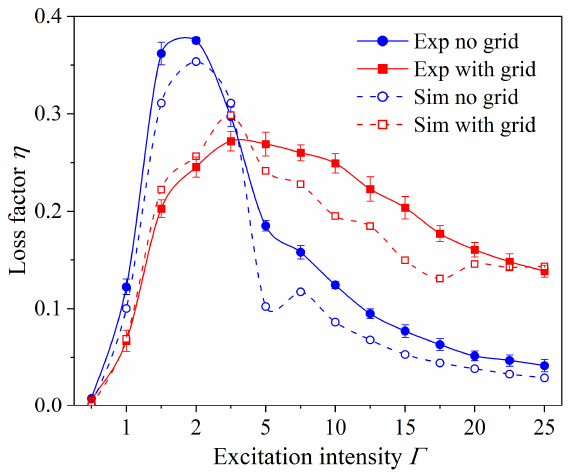
Figure 14. Effect of excitation amplitude on damping performance of particle dampers.